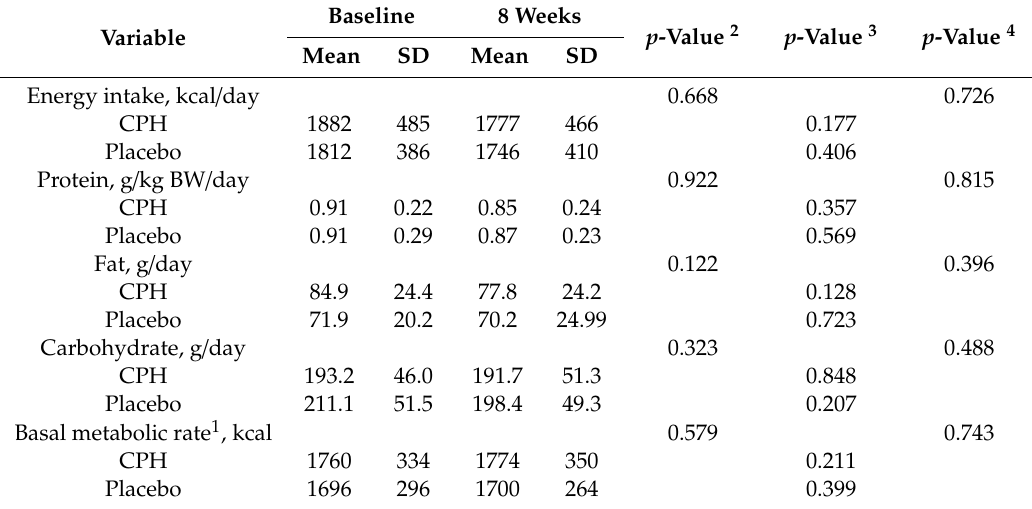
Table 2. Estimated energy and macronutrient intake in the cod protein hydrolysate (CPH) group ( n = 15) and the placebo group ( n = 15) at baseline and end of study (8